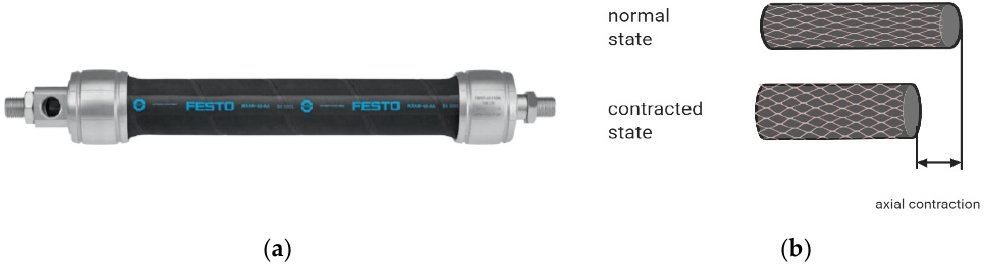
Figure 2. Pneumatic muscle. ( a ) Picture; ( b ) working diagram. Table 1. Characteristics of the investigated pneumatic muscle.